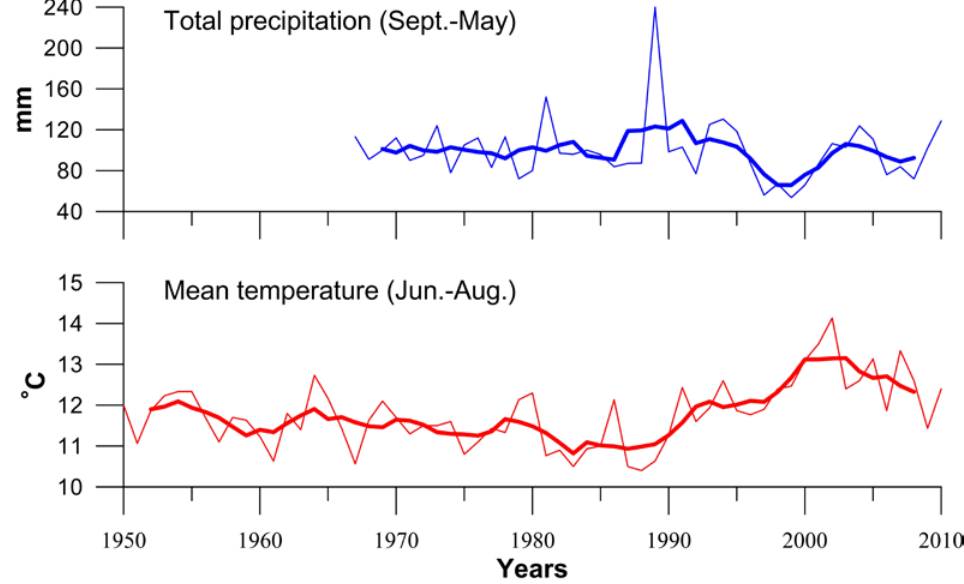
Figure 6. Regional time series of total winter (September–May) precipitation and summer (June– August) temperature recorded at the nearest Orlik weather station (for location see Figure 1). The thick line shows the 5-year moving